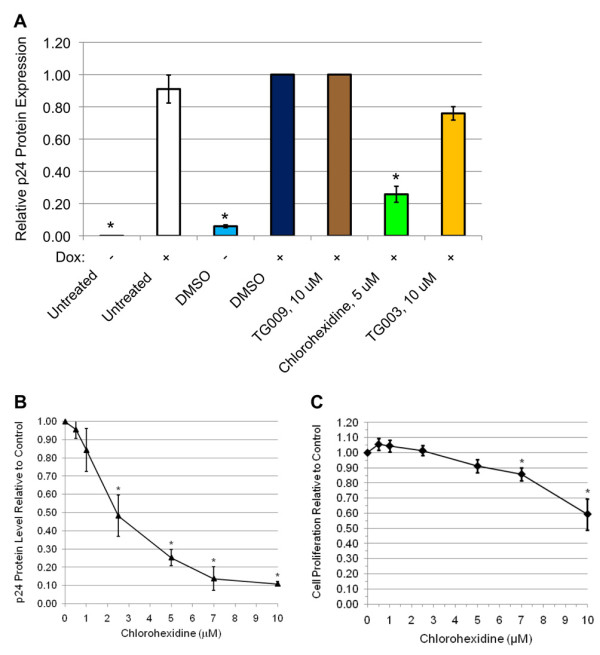
Chlorhexidine is a Potent Inhibitor of HIV-1 Gene Expression. (A) Cells were treated for 4-5 h with TG003, TG009 or chlorhexidine, then doxycycline was added to induce expression of the endogenous HIV-1 provirus. Twenty-four hours later, cell media were harvested, and HIV-1 Gag (p24) protein levels determined by ELISA. Shown are the average of >9 independent assays, asterisks denoting results determined to significantly different from control (DMSO +Dox.) at a p value < 0.01. (B) As described in A, but cells were treated with varying doses of chlorhexidine to identify the minimum dose required to suppress HIV-1 gene expression. (C) To assess the effect of chlorhexidine on cell viability, cells were incubated with indicated dose of chlorhexidine (0.5 - 10 μM) for 24 h then an XTT assay performed. Level of XTT conversion, which measures the number and metabolic activity of the cells, was compared to DMSO-treated cells.